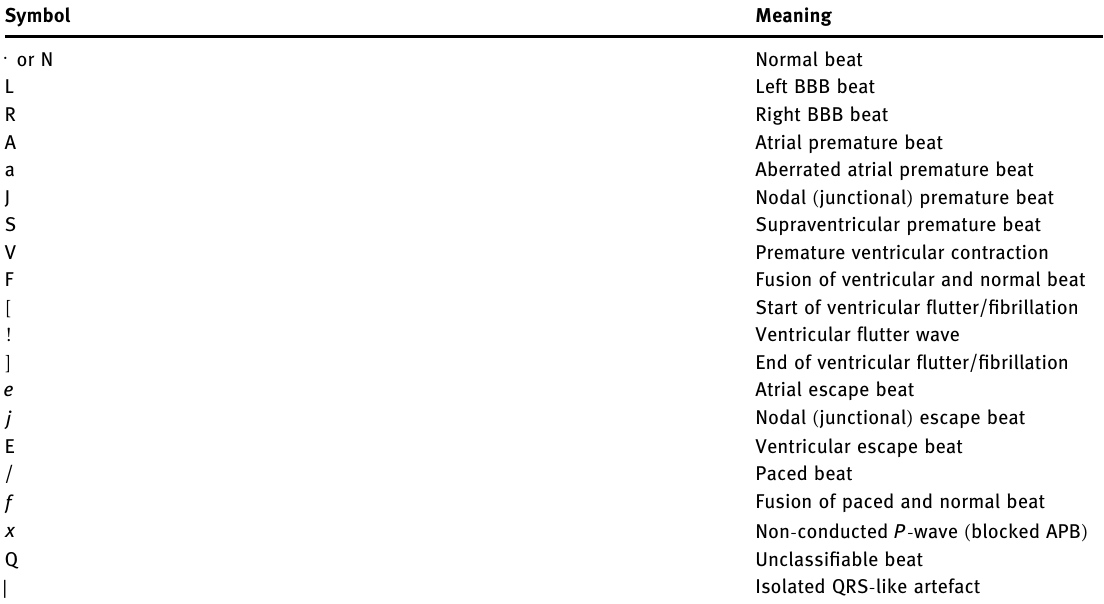
Table 1: Beat annotations used in MIT - BIH database [ 51 ]